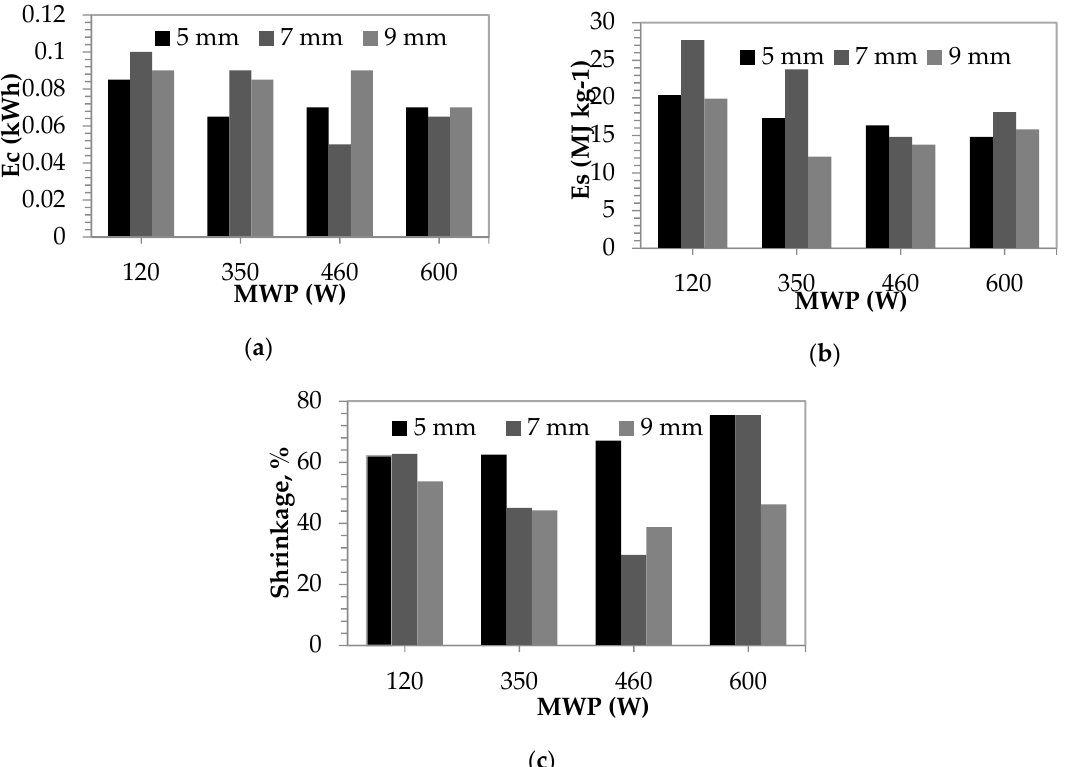
Figure 5. ( a ) Energy consumption values of the microwave dryer, ( b ) the specific energy consumption of the persimmon at varying powers and slices during the drying, ( c ) percentage shrinking of the persimmon during the drying.